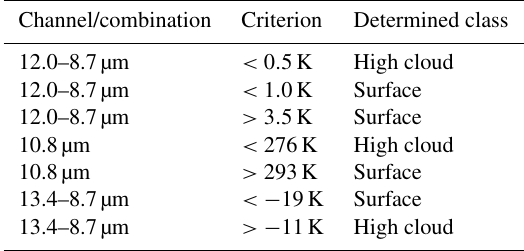
Table 1. The thresholds used for different channels and channel combinations in this study with the outcome of the initial classifica- tion. Threshold values were determined by systematic visual analy- sis of SEVIRI scenes and values found in literature (Cermak,